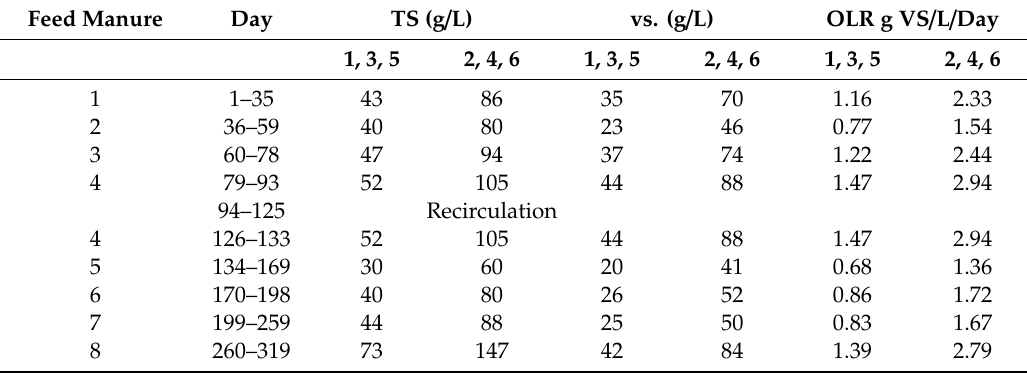
Table 3. Influent concentrations and applied loading rates for the impeller mixed digesters or stirred tank reactors (STR 1 and 2), unmixed digesters (UMD 1 and 2), and the Chinese dome digesters (CDD 1 and 2), Digesters